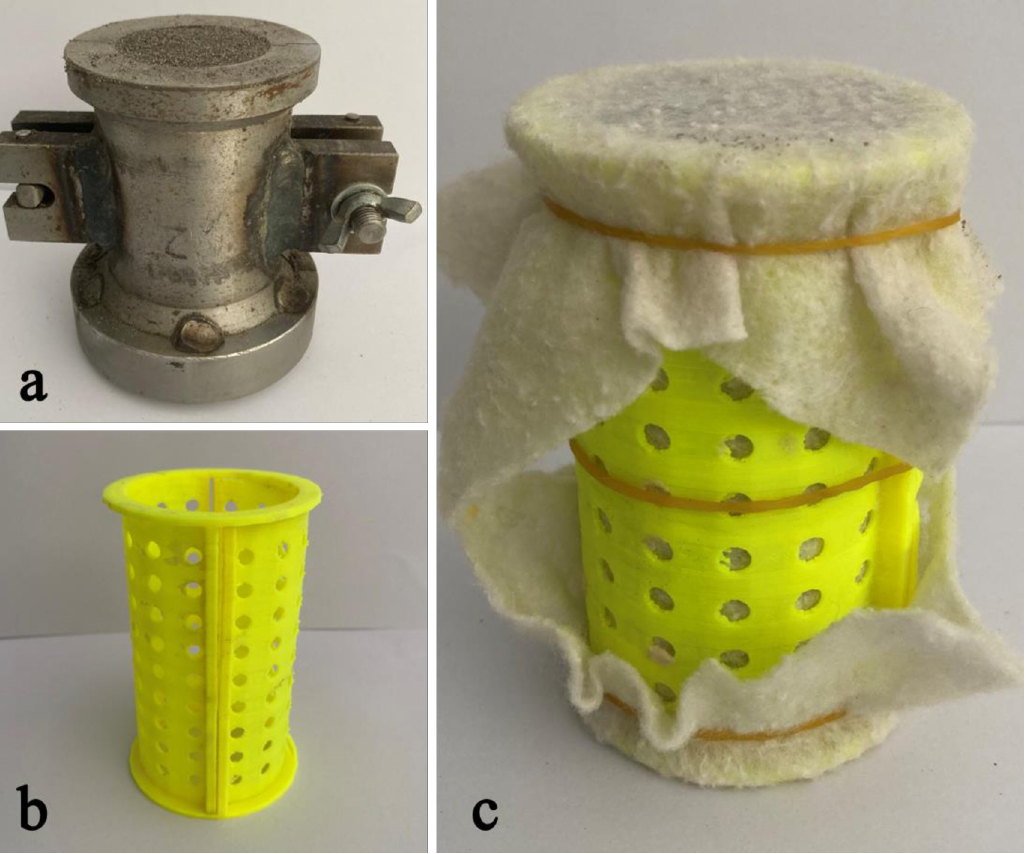
Fig 4. Shaping and preparation of tailings